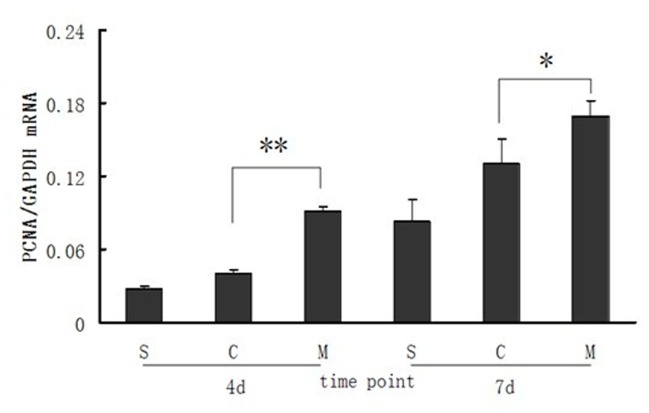
Real-Time PCR analysis of PCNA expression in the intestinal mucosa.Data are means ± SD of each group at different time point and expressed as the ratio of original value mRNA of PCNA to its internal control mRNA of GAPDH. S: sham group; C: control (saline) group; M: MSCs group. 4d and 7d represent 4 days and 7 days postoperatively. ** P<0.01, * P<0.05, compared with control (saline) group, by one-way ANOVA test.